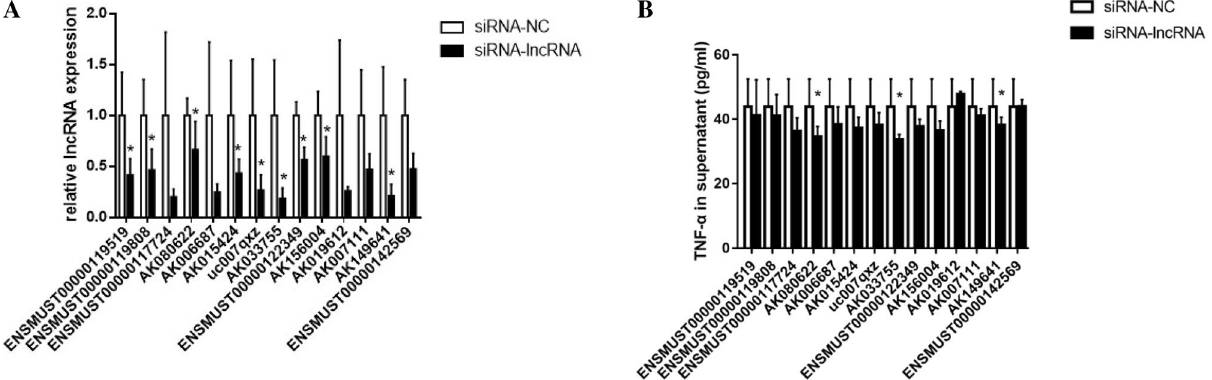
Figure 2. LncRNA-AK149641 regulates TNF-α secretion in P815 mast cells. ( A ) Expressions of 14 candidate lncRNAs are significantly decreased by siRNA treatment. ( B ) Concentration of TNF-α in the supernatants (* P < 0.05, n = 3).